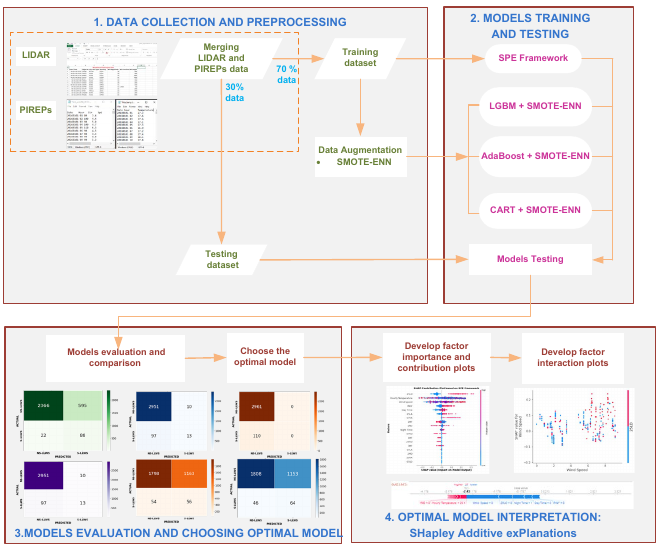
Figure 1. Framework for the prediction and interpretation of LLWS severity in the vicinity of runways.